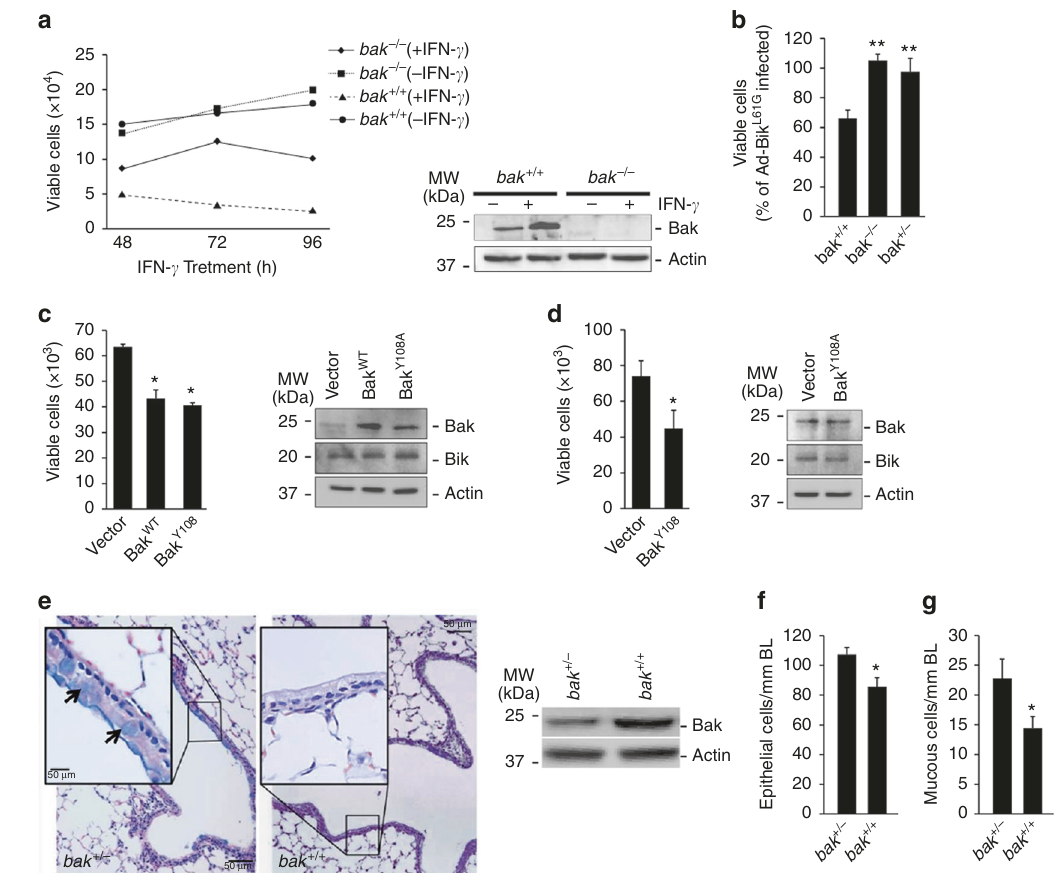
Fig. 2 Bak mediates IFN- γ - or Bik-induced cell death and resolution of ECH and MCM during prolonged exposure to allergen. a MAECs isolated from bak − / − and bak + / + mice treated with 50 ng/ml murine recombinant IFN- γ or left untreated as controls and viable cells quanti fi ed 24, 48, and 72 h later with Trypan blue. Protein lysates were analyzed for the expression level of Bak by western blot. b MAECs from bak + / + , bak − / − , and bak + / − mice were infected with 100 MOI Ad-Bik or Ad-Bik L61G , and cell viability was quanti fi ed 24 h later. c MAECs from bak − / − mice were infected with empty vector or retroviral expression vector for Bak WT or mutant constitutively activation competent form of Bak (Bak Y108A ). Cells were collected and quanti fi ed by trypan blue exclusion assay and protein lysates were analyzed by western blotting. d MAECs from bak + / − mice were infected with empty vector and retroviral expression vectors for mutant constitutively activation competent form (Bak Y108A ) of Bak. And 48 h later, cells were infected with 100 MOI Ad-Bik for 24 h. Cells were collected and quanti fi ed by trypan blue exclusion assay and protein lysates were analyzed by western blotting. e Representative micrographs of bak + / + and bak + / − mice that were immunized with ovalbumin/alum on d 1 and 7, and were exposed to ovalbumin aerosols for 15 d. After killing, the lungs of each mouse were fi xed and tissue sections were stained with Alcian blue/hematoxylin and eosin (AB/H&E) for quanti fi cation. Protein lysates of airway epithelial cells from bak + / − and bak + / + mice were analyzed for Bak protein levels by western blotting. The numbers of epithelial f and mucous g cells per millimeter of basal lamina in b ak + / + mice but not in bak + / − mice at 15 d of exposure. Differences between two groups were assessed for signi fi cance by Student ’ s t test. ANOVA was used to perform pair-wise comparison of the data from more than two groups followed by Fisher least signi fi cant difference test. Error bars indicate ± SEM; ( n = 8 mice per group). * = P < 0.05; ** = P <